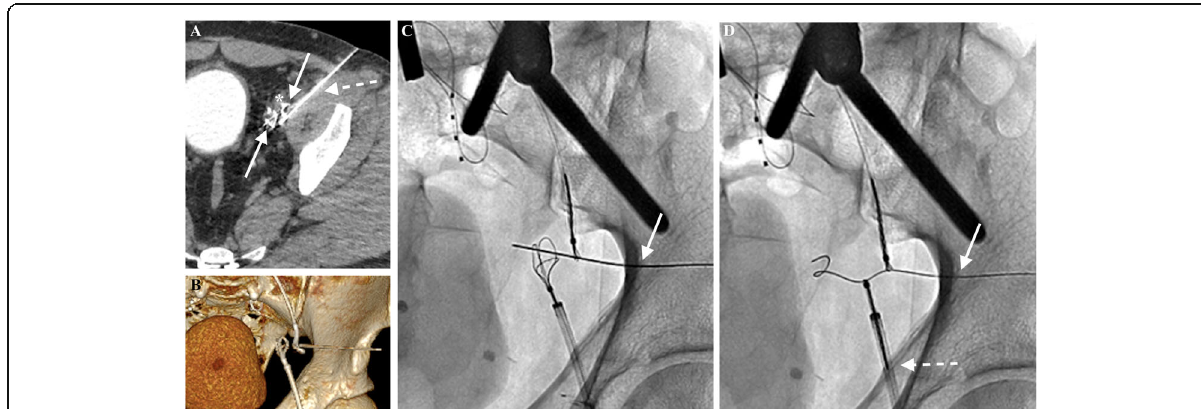
Fig. 2 a Axial hybrid CT images confirmed the two snares (solid arrows) in close proximity to each other, with an adjacent external iliac artery (asterisk). A 21G needle (dotted arrow) was advanced percutaneously through the snare catheters using intermittent CT guidance, allowing a safe trajectory to avoid puncture of the artery and to reduce the potential for damage to adjacent structures; b Additional three-dimensional reformat show the trajectory of the needle (arrows) through the vascular snares; c Switching from CT to fluoroscopy allowed real-time adjustment and advancement of the needle (arrow) through both snares while avoiding the artery, utilizing the “ gun-sight ” approach without complication (Haskal et al. 1996); d A V-18 wire (solid arrow) was advanced through the needle access and snared through the LCFV access (dotted arrow). The needle was safely removed under fluoroscopy, and through-and-through “ flossing ” access was achieved with the following technique: the wire and snare were pulled out from the groin access, and a 0.018 ″ Quick-Cross catheter (Spectranetics, Colorado Springs, CO) was advanced over the wire through the superior snare and then snared from above with the wire removed. The wire was then re-advanced, snared, and pulled out from the neck access site